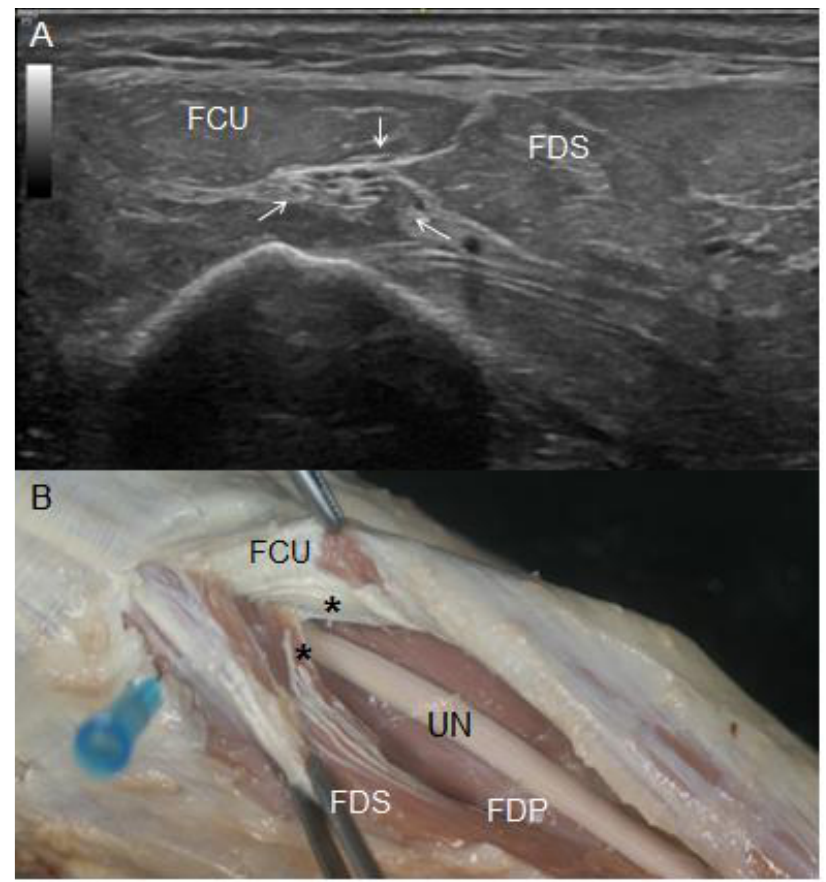
Figure 8. ( A ) Ultrasound view of the UN (white arrows) between the FCU and flexor digitorum superficialis (FDS) at the upper third of the forearm. ( B ) Anatomical view of the UN at this very point of the forearm. Note how it crossed beneath an aponeurotic structure (black asterisk), compressing the insertion of tendinous fibres of the FDS on the FCU muscle fibres. In this figure, UN was dissected from the FDS’s epimysium in which it was included, and it rests on FDP muscular